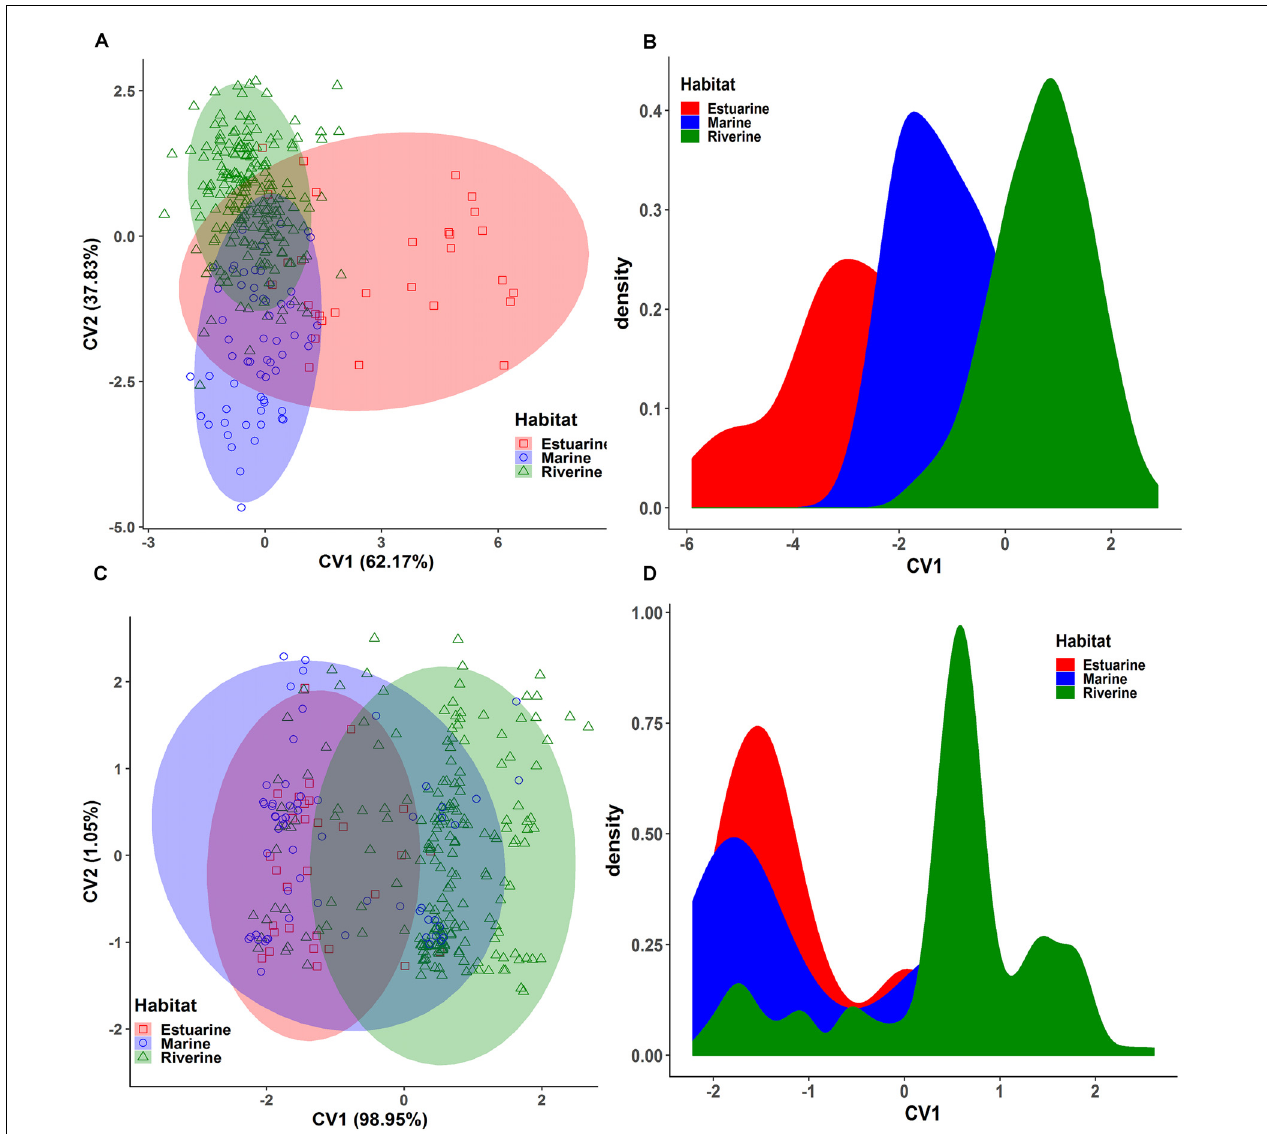
FIGURE 4 | The Canonical Variate Analysis (CVA) showing the morpho-genetic variation of Hilsa shad Tenualosa ilisha collected from the marine (salinity 30.3–33.4 ppt), estuarine (salinity 2.5 to 20.6 ppt) and riverine (salinity < 1.0 ppt) habitats. Biplots of sample centroids of the canonical variates scores are shown based on the 22 truss morphometric length (A,B) and 74 putatively adaptive panels of SNP loci identified by the F ST OutFLANK approach (C,D) .